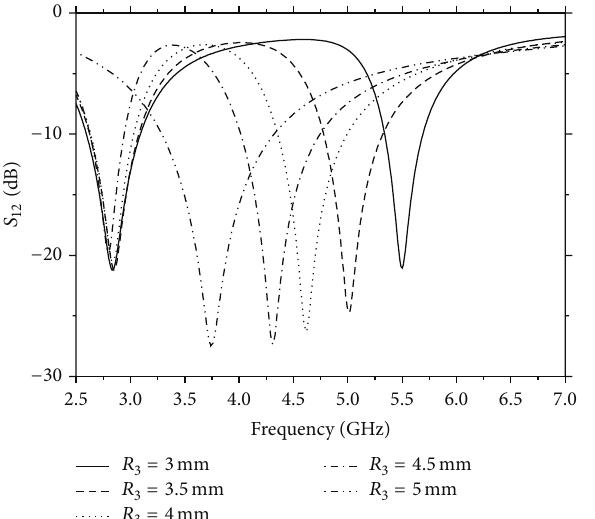
Figure 4: The transmission coefficient of the filter with variation of 𝑅